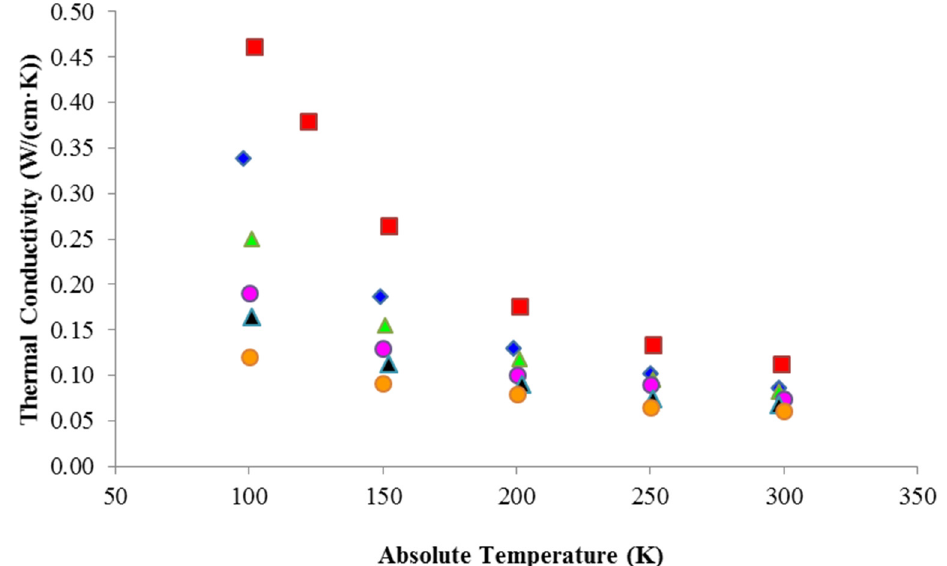
Figure 4. Thermal conductivity as a function of absolute temperature for undoped single-crystal Czochralski-grown YAG (red), and Yb:YAG with doping densities of 2 (blue), 4 (green), 10 (pink), 15 (black), and 25 (orange) at. %. The experimental data for the 2, 4 and 15 at. % values are taken from [29], while the 10 and 25 at. % values were determined from fits to the data of [29] for each temperature.